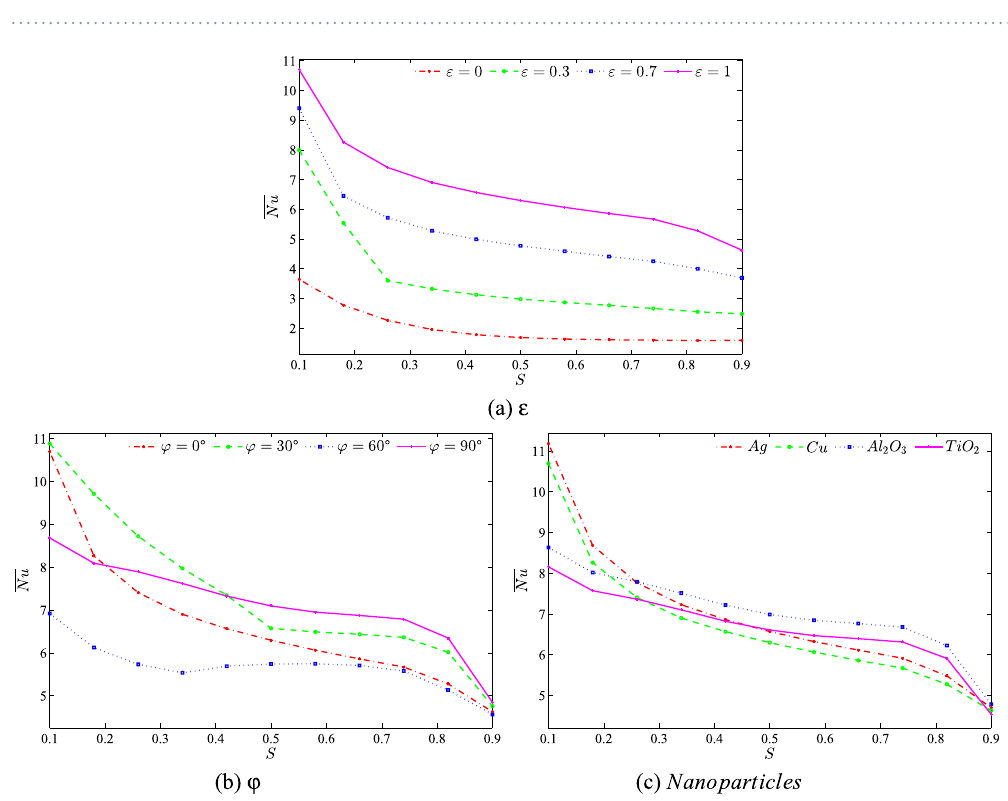
Figure 14. Values of Nu interfaces with S for ( a ) different ε , ( b ) different ϕ and ( c ) different sp at Ra bf = 10 5 , Da = 10 − 4 , γ = π and φ = 2